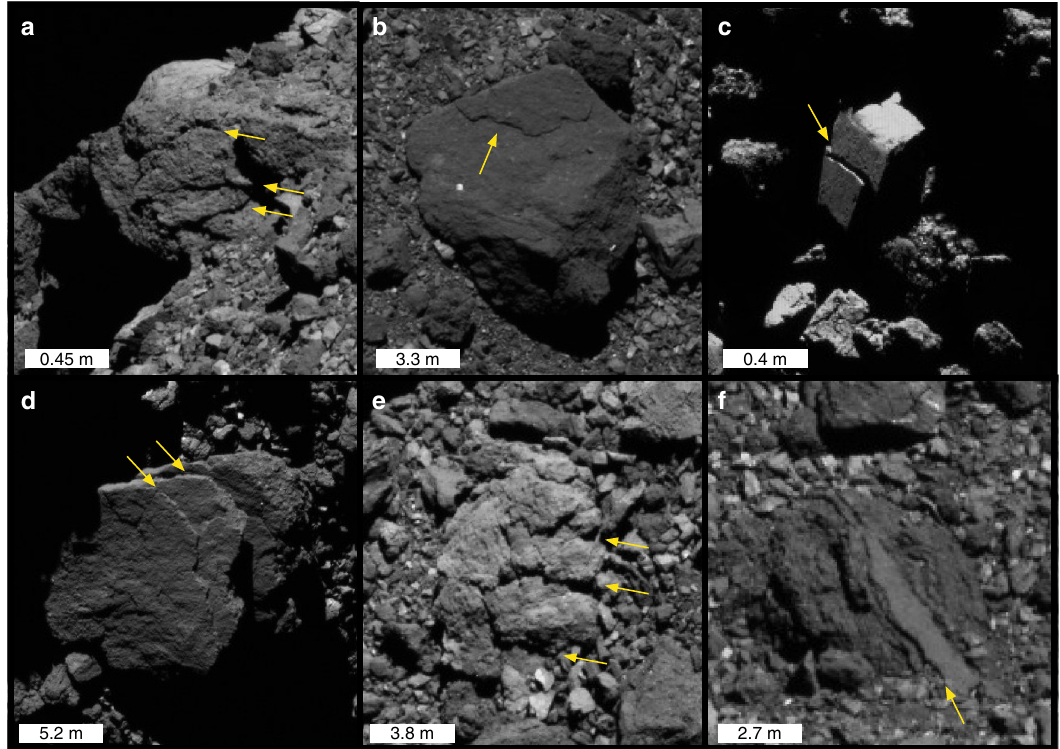
Fig. 1 Exfoliation features observed on Bennu. Exfoliation features on a cliff face ( a ) and on boulders ( b – f ) with varying size and location. Object coordinates and attributes are given in Table 1. The bright dome on the horizon of ( a ) is a boulder behind the exfoliating breccia clasts, such as the boulder below the cavity in Fig. 2b. Fig. 2c represents a case in between, featuring a smooth